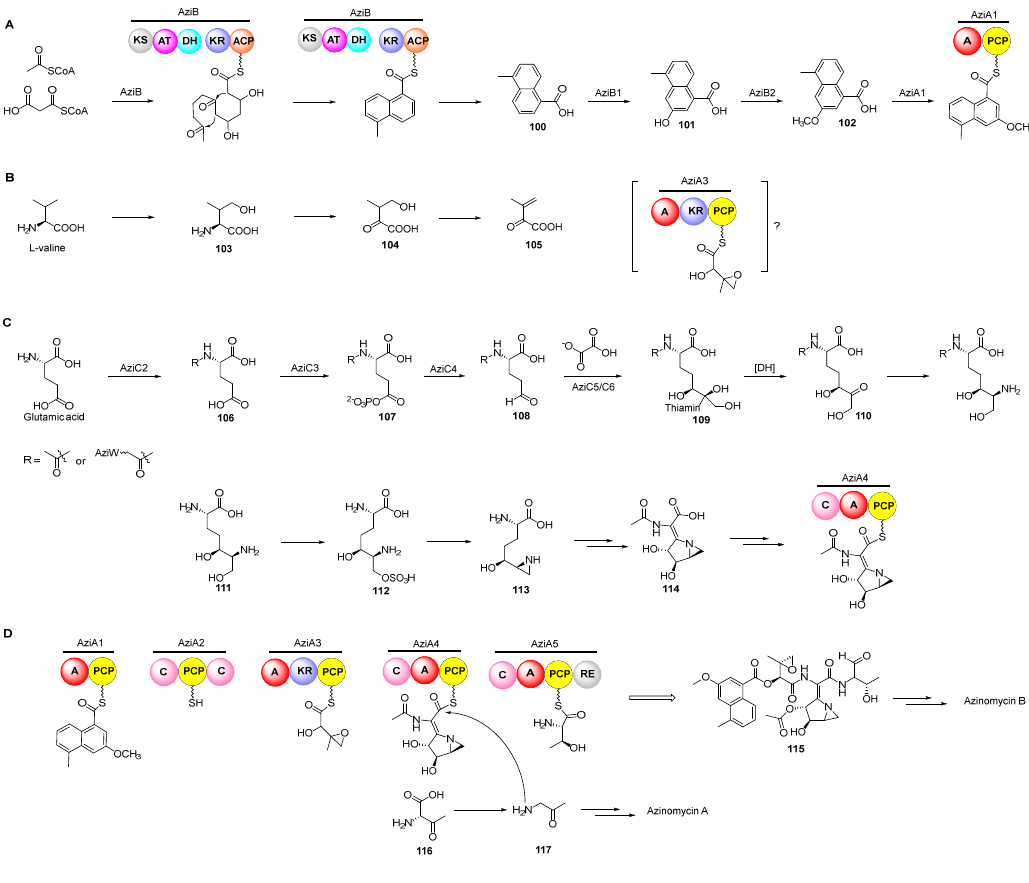
Figure 14. Proposed biosynthetic pathway of azinomycins. PCP, peptidyl carrier protein; A, adenyl- ation; C, condensation; RE, reduction. Proposed pathway of constructing 3-methoxy-5-methyl-NPA moiety ( A ), epoxy intermediate ( B ), azabicyclic fragment ( C ), and incorporating building blocks ( D